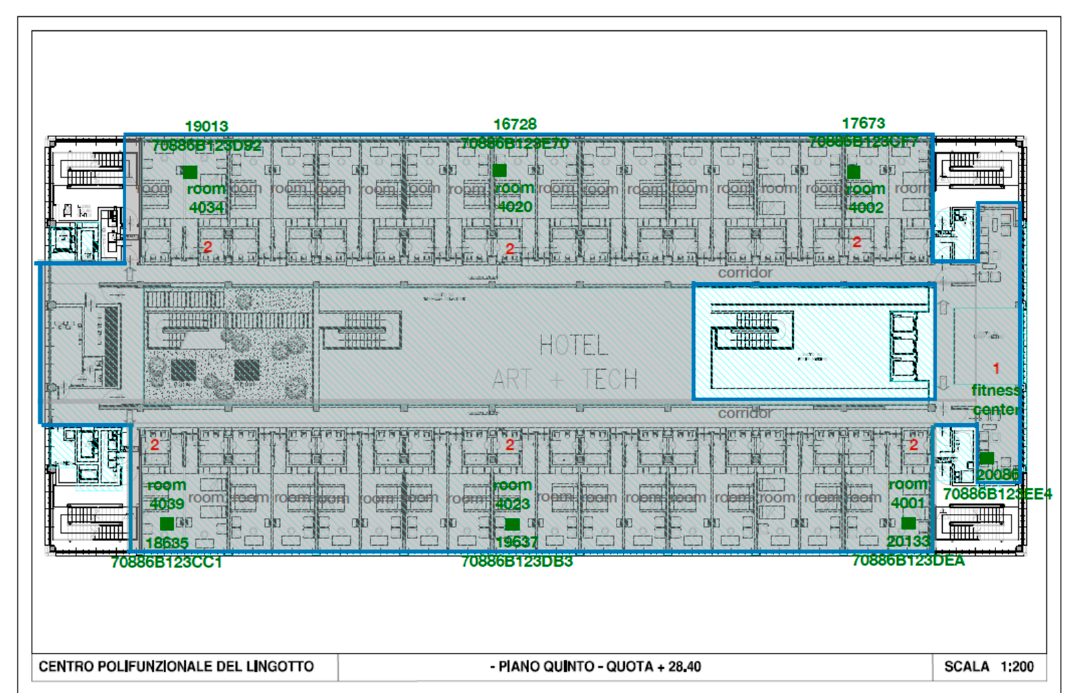
Figure 5. Floorplan of the rooms and fitness center area, fifth floor, with indication about the placing of the monitoring platform.